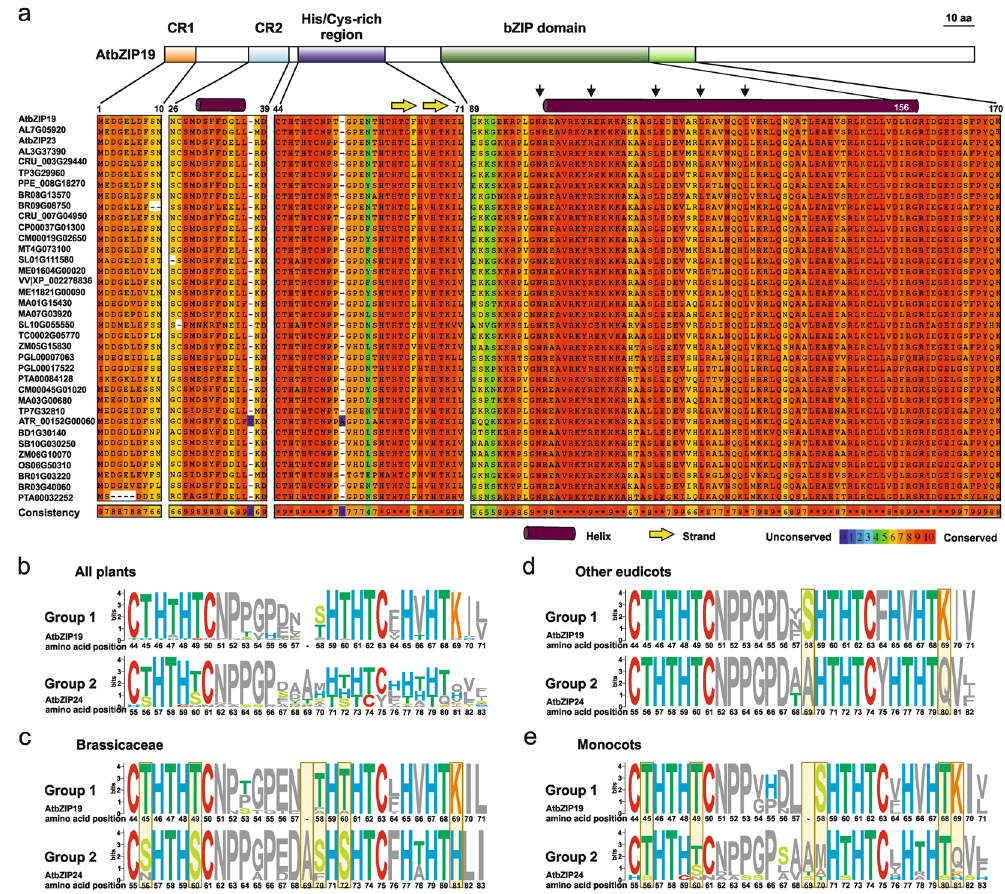
Figure 2. Conserved domain analysis of F-bZIP proteins. ( a ) Multiple sequence alignment of conserved regions matching significant protein motifs and domains of the Group 1 F-bZIPs. Amino acid consistency is classified from 0 (unconserved) to 10 (conserved); perfect amino acid match in all species is indicated with an asterisk. CR1/2 stands for conserved region 1 or 2. The AtbZIP19 was used as reference sequence. Secondary structure was predicted for AtbZIP19 and displayed on top of the alignment. Inset arrows represent highly conserved residues of the bZIP domain consensus sequence [N-X7-R/K-X9-L-X6-L-X6-L]. Sequence logo were used to compare the His/Cys-rich motif between F-bZIP Groups 1 and 2 in all plants. Four sequences with this motif missing or incomplete were not included (Fig. 1a) ( b ), Brassicaceae species (c) , other Eudicots (only the ones which also have an F-bZIP from group 2, T. cacao , P. persica and V. vinifera ) ( d ), and Monocots ( e ). Letters denote amino acids and the height amplitudes indicate the degree of conservation for the amino acids in that position. The amino acid number position is in relation to AtbZIP19 for F-bZIP Group 1 and AtbZIP24 for F-bZIP Group 2 proteins. Colours highlight amino acids of interest. Yellow boxes highlight the most divergent amino acids between Groups 1 and